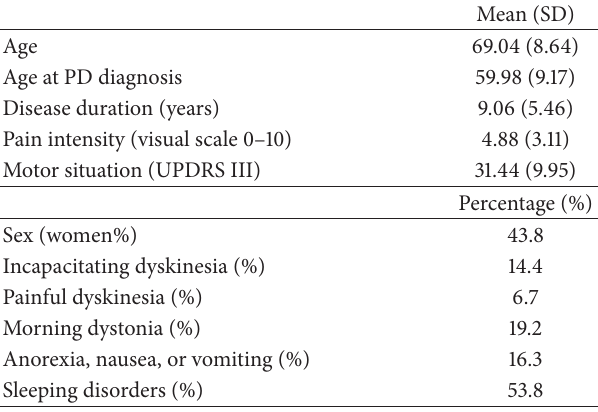
Table 5: Baseline characteristics ( 𝑛 = 105 ).